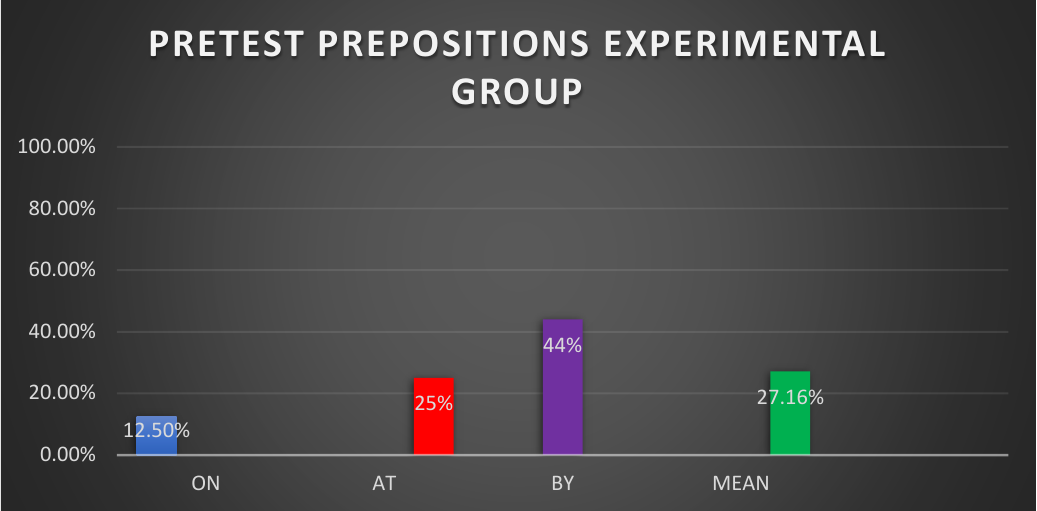
Figure 2. Experimental group pretest and mean.